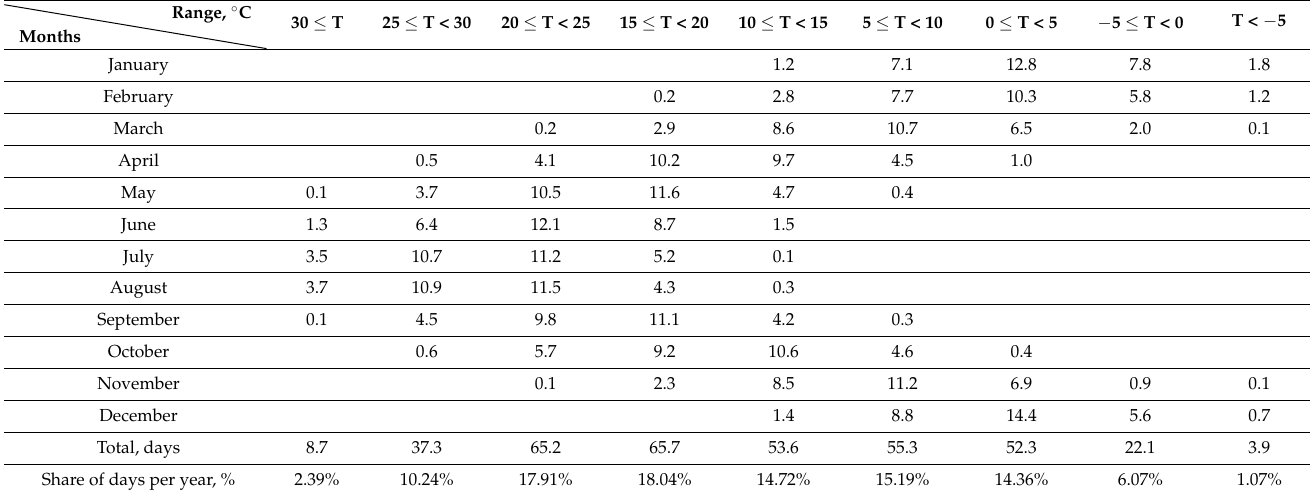
Table 8. Number of days with specific temperature ranges occurring in each month,